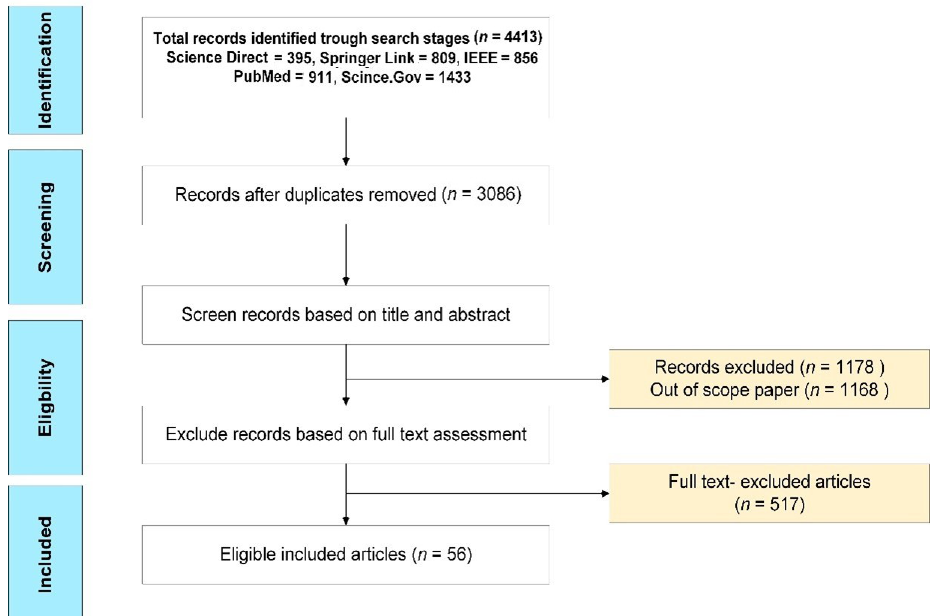
Figure 1. Steps used to select